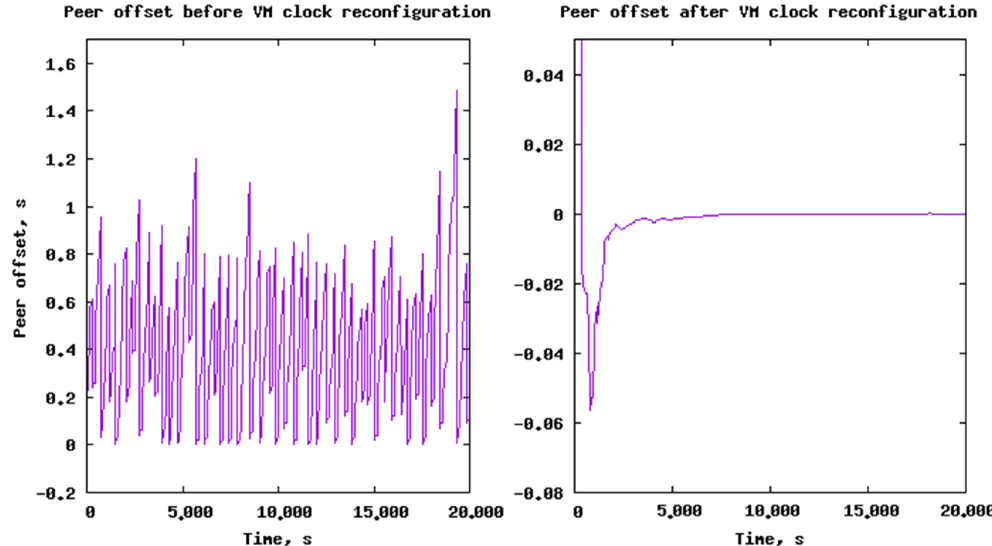
Figure 9. ( Left ): NTP offset between the local system clock and the timeserver clock before the system clock reconfiguration. ( Right ): NTP offset between the local system clock and the timeserver clock after the system clock reconfiguration.